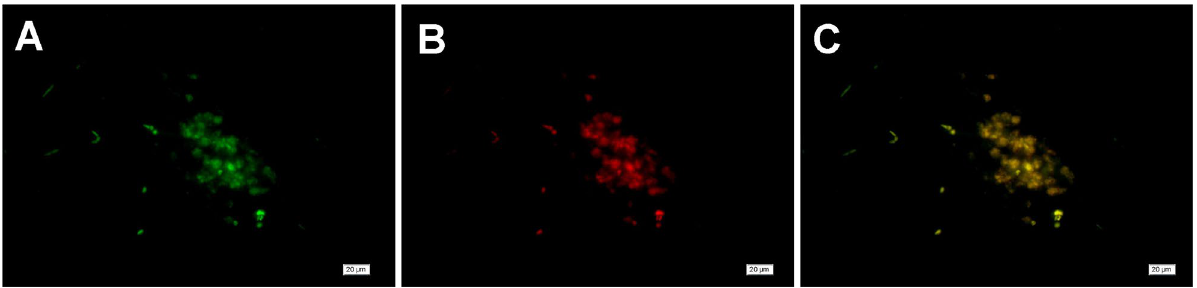
Figure 6. Double immunofluorescence staining images showing LYVE-1/PROX1 expression in brain tissue 7 days after pTBI. Expression of ( A ) LYVE-1 (green); ( B ) PROX1 (red); and ( C ) merge